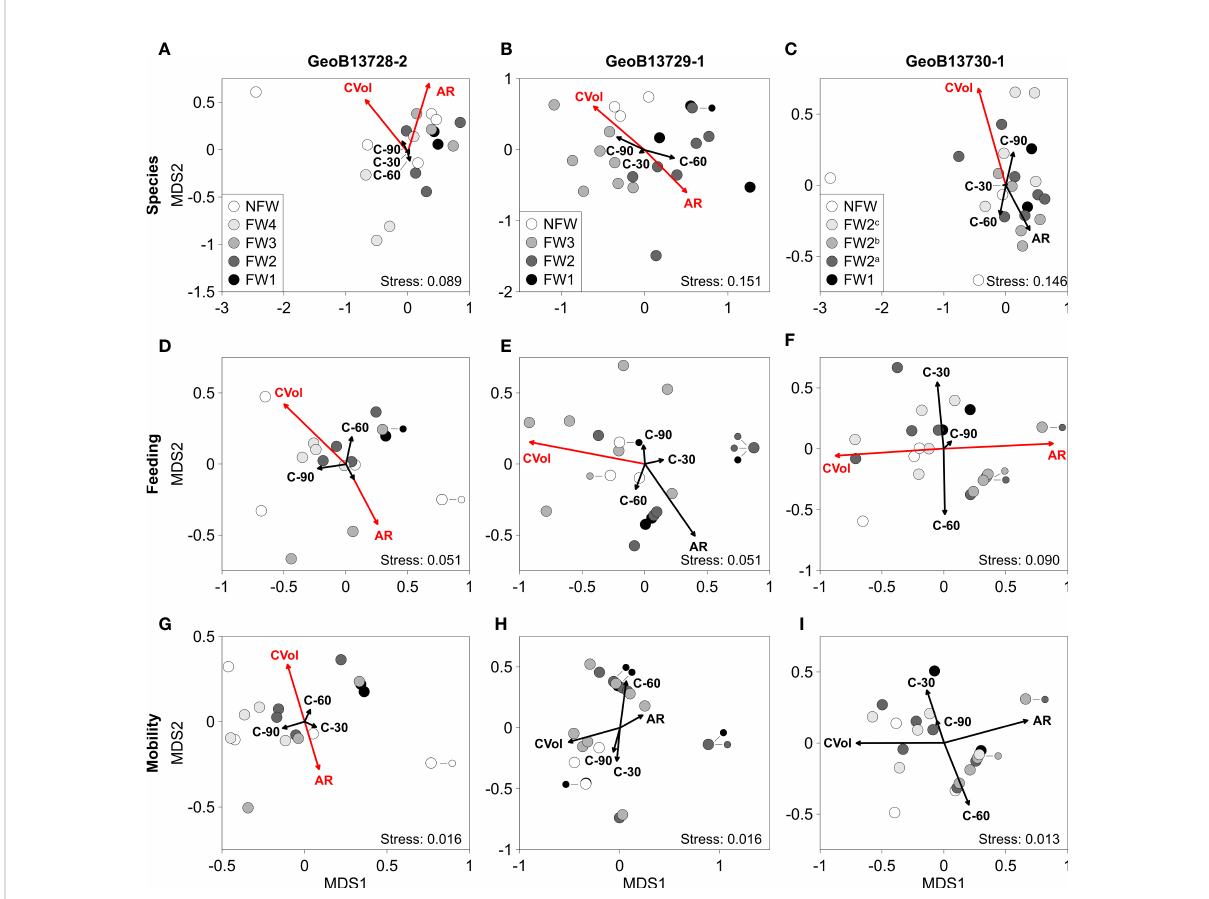
FIGURE 7 Non-parametric multi-dimensional scaling (nMDS) plots of molluscan species (A, D, G) , feeding groups (B, E, H) , and mobility groups (C, F, I) with rotational vector fi tting of habitat characteristic parameters for cores GeoB13728-2, GeoB13729-1, and GeoB13730-1. Color coding of molluscan assemblages (circles) corresponds with intervals of coral framework (FW) and non-framework (NFW) identi fi ed in Supplementary Figure 1. For core GeoB13730-1, FW2 is subdivided into three (nearly) equal groups due to the large number of assemblages within FW2. See Figure 6 for description of vectors. Habitat characteristic parameters: AR – mound aggradation rate calculated from AMS 14 C coral ages (Fink et al., 2013) and U/Th coral ages converted to kyr BP (this study and Wang et al., 2021); CVol – coral volume (percentage of total core volume); C-30 – percentage of coral branches orientated 0-30°; C-60 – percentage of coral branches orientated 30-60°; C-90 – percentage of coral branches orientated 60-90°. Coral volume and orientation data extracted from CT data (this study: GeoB13728-2, GeoB13730-1; Titschack et al., 2016: